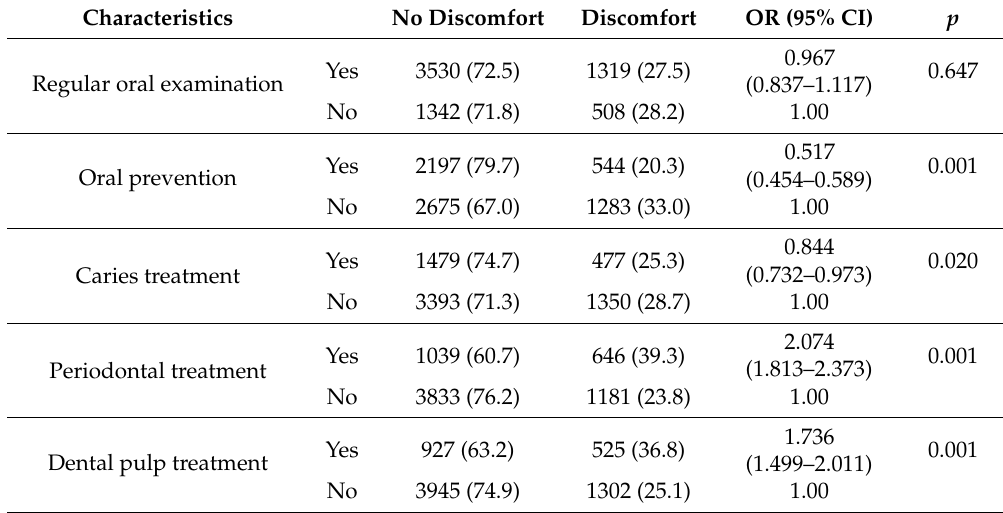
Table 2. Comparison of dental treatment according to mastication